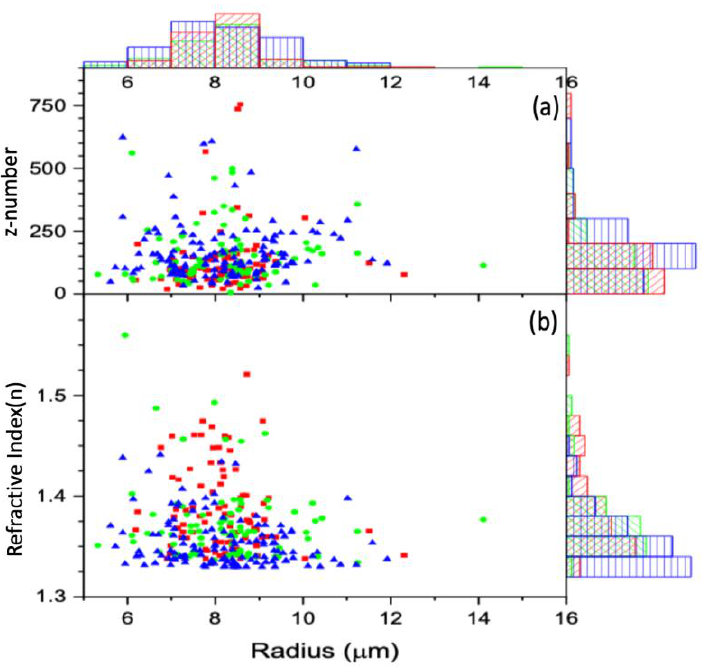
Figure 5. The calculated z number ( a ) and refractive index ( b ) vs. the radius for each cell, along with the corresponding distributions, are displayed using histograms: control (red), 2 h-treated (green), and 24 h-treated (blue). Both the refractive index and z number are unitless.